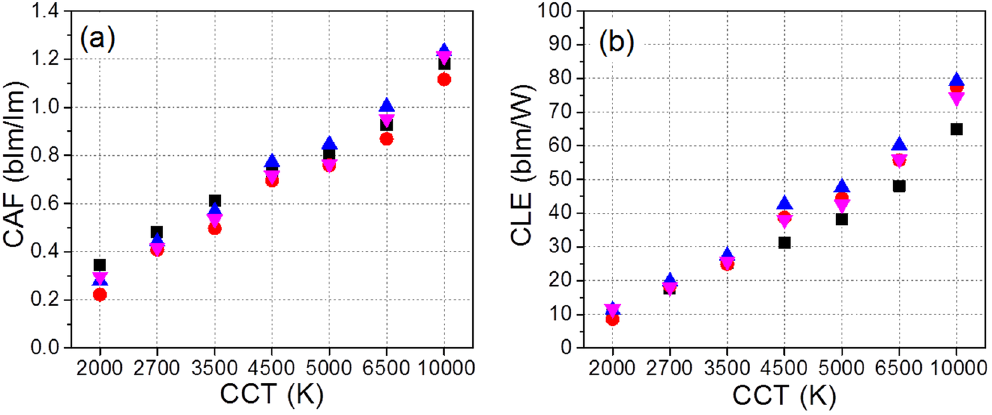
Figure 7. The relationship of ( a ) CAF-CCT, and ( b ) CLE-CCT among the three- to six-package